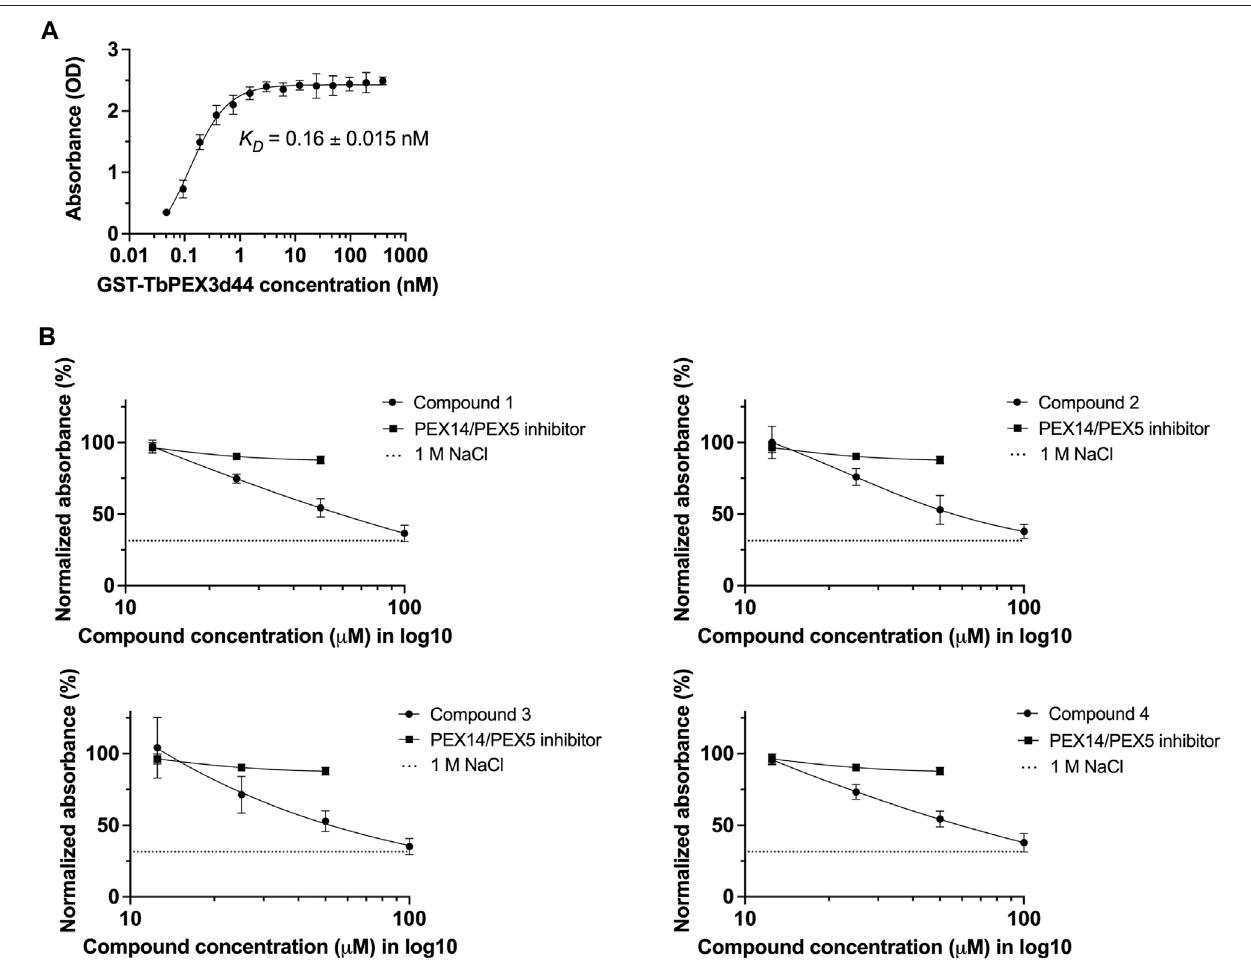
FIGURE 3 | Validation of TbPEX3 – TbPEX19 interaction inhibition using ELISA assays. (A) 1 µg of PEX19-His was coated to the wells of ELISA plate, blocked with BSA followed by incubation with different concentrations of GST-TbPEX3d44. Unbound PEX3 was removed, and bound PEX3 was detected using anti-GST primary antibody, horseradish peroxidase (HRP) – coupled secondary antibody, TMB as colorimetric substrate, and detection of absorbance at 450 nm. The binding curve of GST-TbPEX3d44 and TbPEX19FL-His was fi tted using a simple 1 to 1 binding model and an apparent K D value of 0.16 ± 0.015 nM was estimated (n (cid:2) 2). (B) Dose-dependent inhibition of PEX3 – PEX19 interaction by all four selected compounds was con fi rmed with ELISA assays. A TbPEX14 – TbPEX5 inhibitor was used as a negative control. Incubation with 1 M NaCl abolished the interaction.